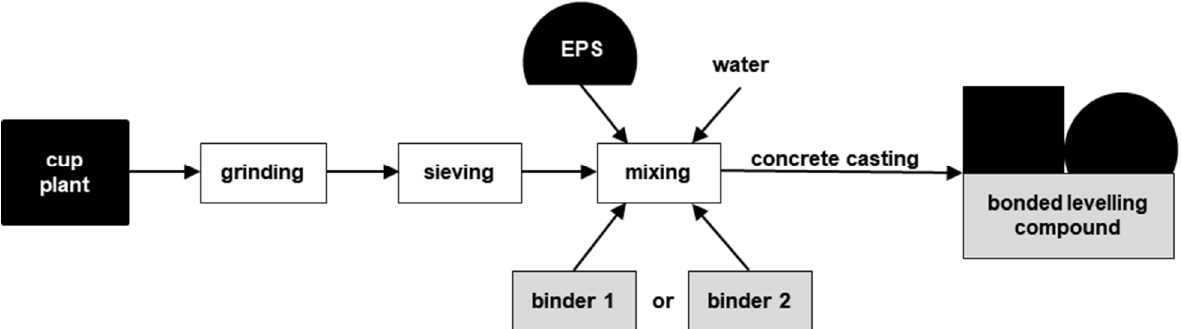
Figure 1. Schematic depiction of the study design. Grinding and sieving of the cup plant biomass, followed by mixing with expanded polystyrene (EPS), water, and one of the binders. followed by mixing with expanded polystyrene (EPS), water, and one of the